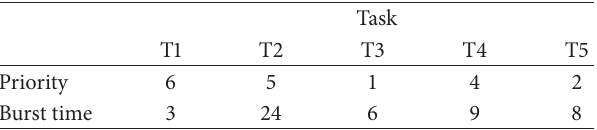
Table 1: Example Task Set 1.